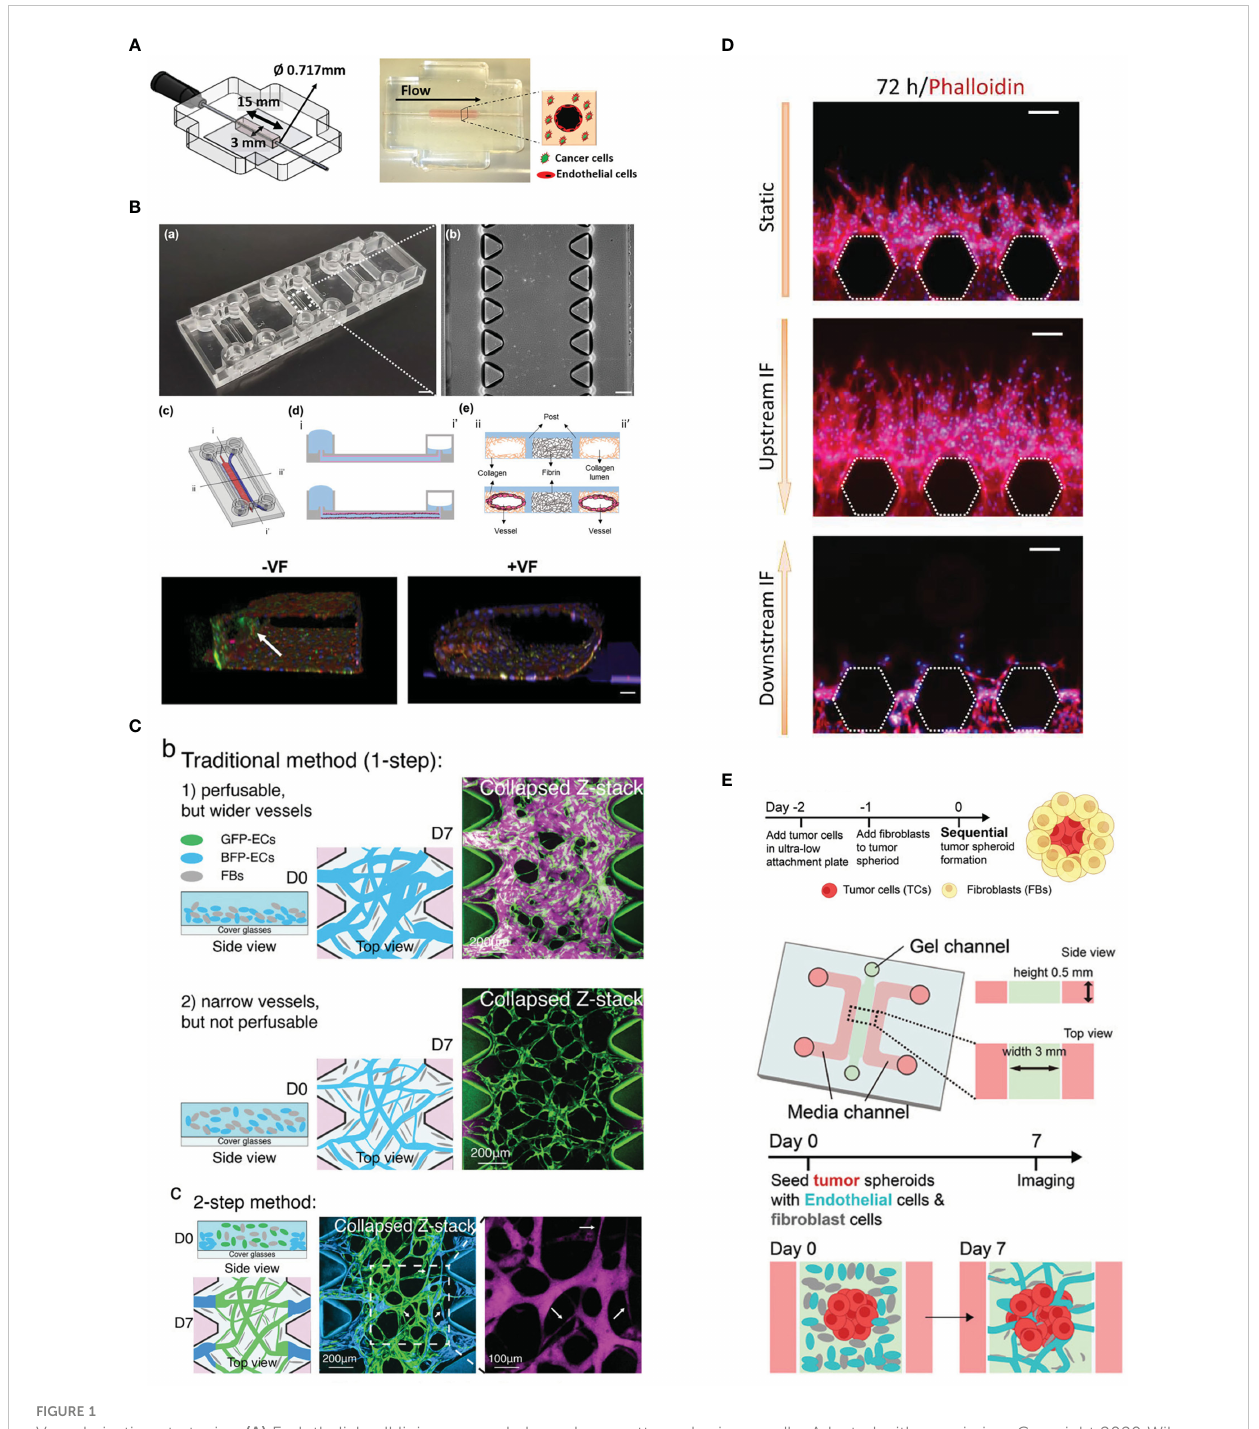
FIGURE 1 Vascularization strategies. (A) Endothelial cell lining on a gel channel pre-patterned using needle. Adapted with permission. Copyright 2020 Wiley Periodicals LLC. (B) The viscous fi ngerprinting method is used to line the micro fl uidic channels, ensuring a more even endothelial cell